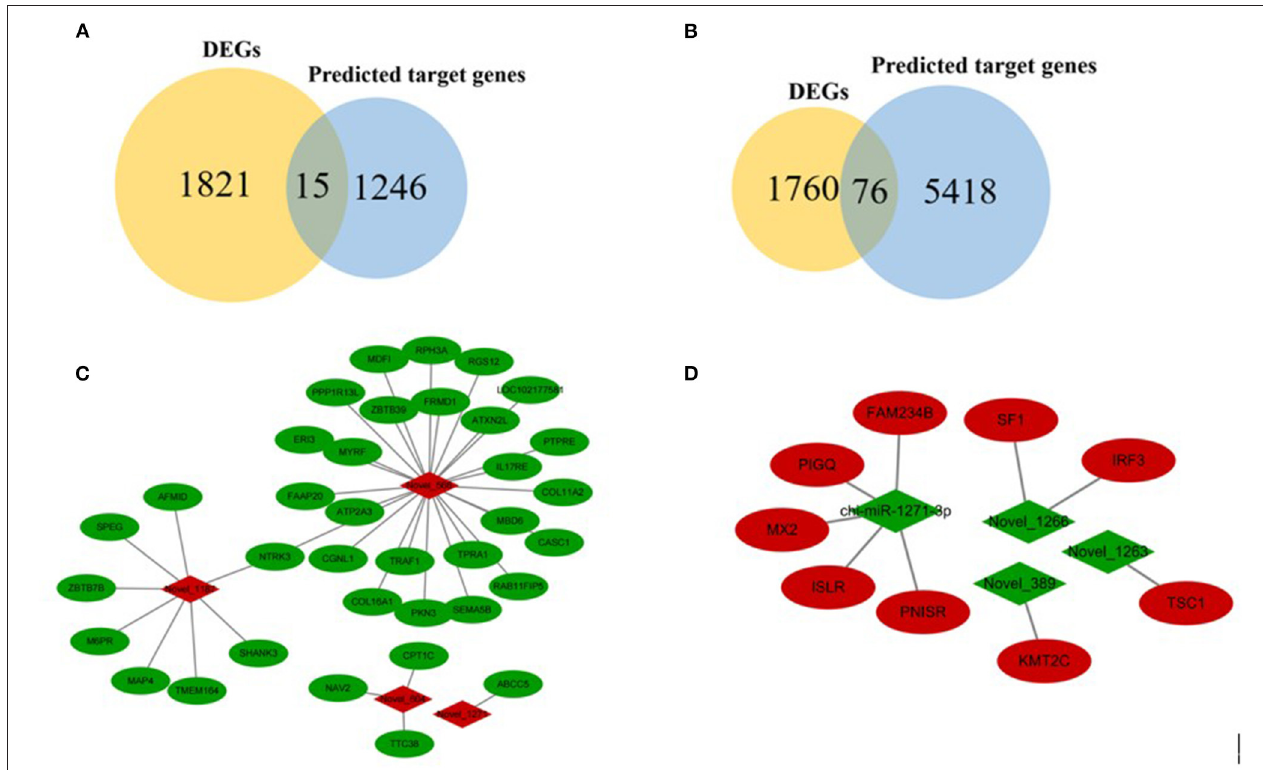
FIGURE 6 | Overview of mRNA-miRNA networks. (A) Intersected genes in FP-HY vs. FP-LY between DEGs and predicted target genes by known miRNAs. (B) Intersected genes in FP-HY vs. FP-LY between DEGs and novel miRNA-targeted genes. (C) Main hypothalamic upregulated network in FP-HY vs. FP-LY containing the 4 upregulated miRNAs and 36 target genes. (D) Main hypothalamic downregulated network in FP-HY vs. FP-LY containing the 4 downregulated miRNAs 4 and 9 target genes. Red and green indicate up- or down-regulation, respectively.